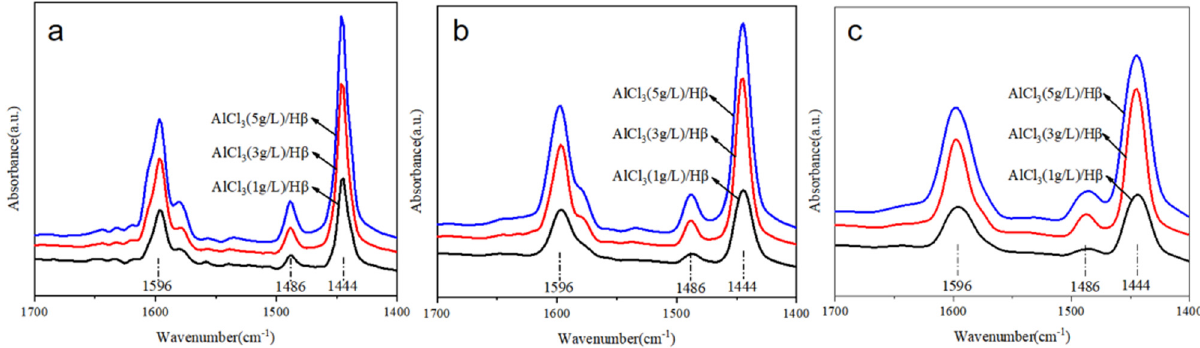
Figure 4: Py - IR spectra of AlCl 3 /H β catalysts prepared with di ff erent concentrations of AlCl 3 : ( a ) 150°C, ( b ) 300°C, and ( c ) 450°C.